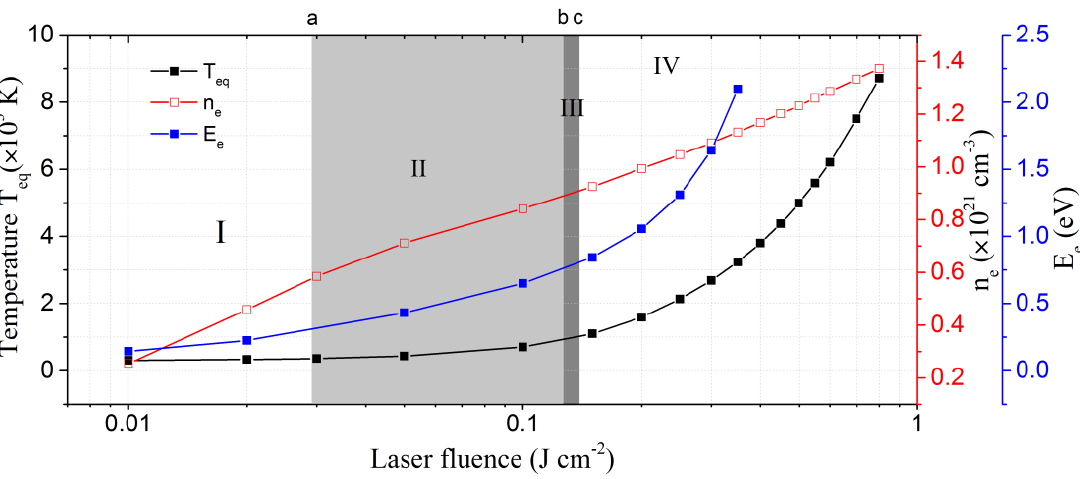
Figure 6. Electron – phonon equilibrium temperature T eq , maximum density of free electrons n e , and maximum kinetic energy of the electrons E e , as a function of the laser fluence ranging from 0.01 J cm −2 to 0.8 J cm −2 .